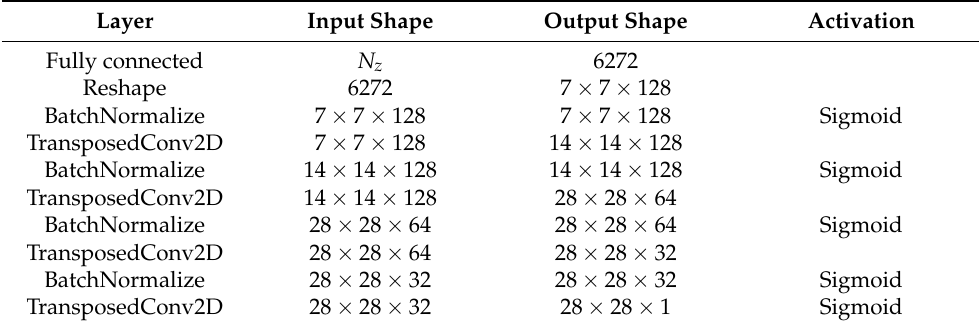
Table 3. The architecture of the generator, G .